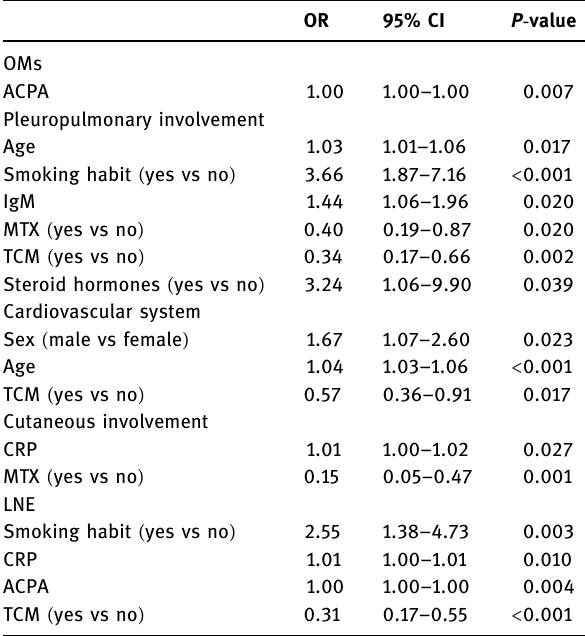
Table 3: Binary logistic regression analysis of tissue - speci fi c/ systemic EAMs